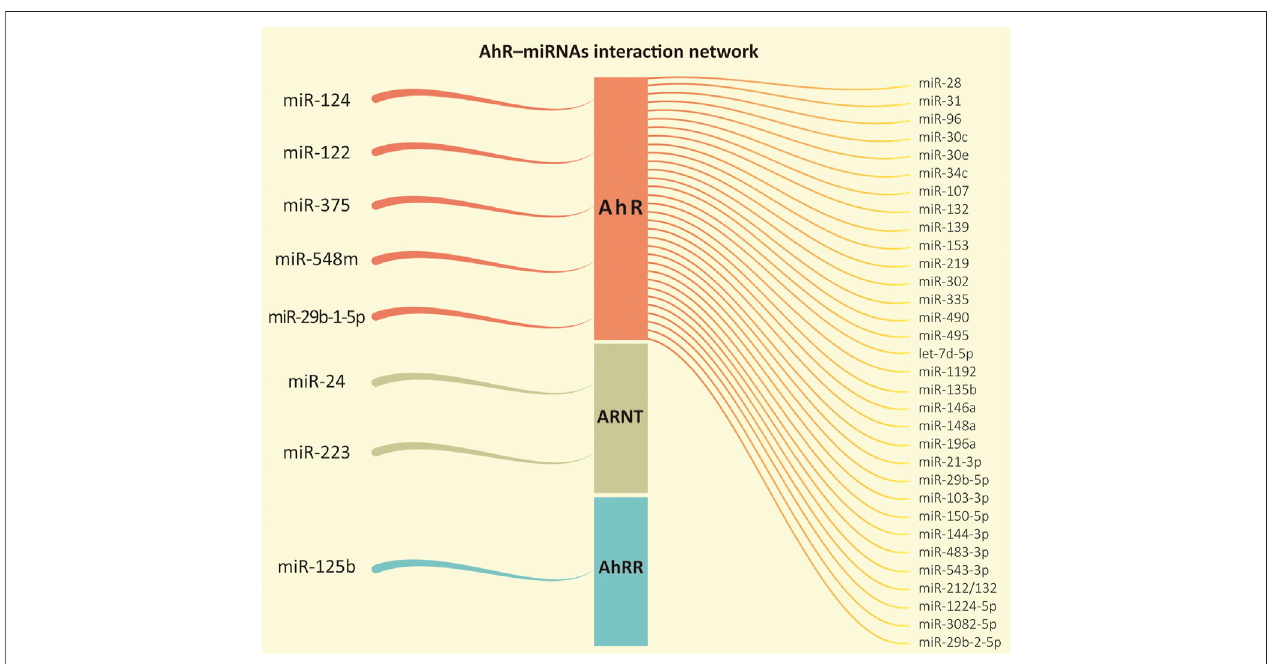
FIGURE 3 | AhR-miRNAs interaction network. From left to right, it represents the microRNAs whose functions were recorded regulating one of the proteins in the aryl hydrocarbon receptor (AhR) signaling pathway followed by the miRNAs regulated downstream by the transcription factor AhR according to our review.